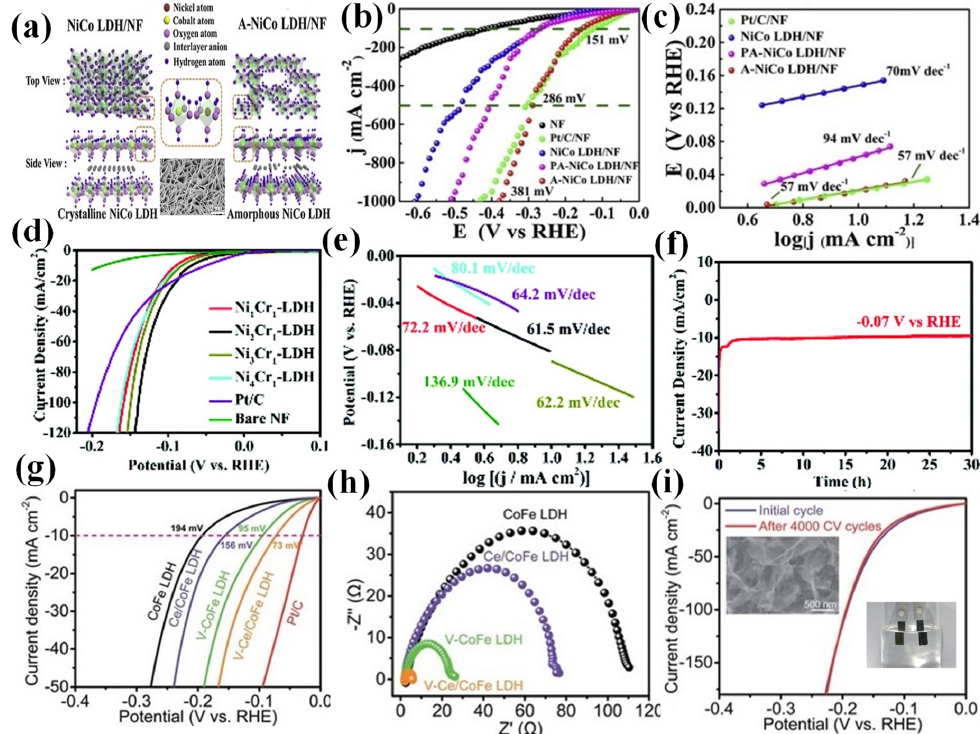
Figure 9. ( a ) Structure of boron-doping-induced amorphization of crystalline Ni-Co LDH nanosheets supported on nickel foam (denoted as A-Ni-Co LDH/NF); ( b ) LSV polarization curves and ( c ) Tafel plots of bare NF, Pt/C/NF, NiCo LDH/NF, PA-NiCo LDH/NF and A-NiCo LDH/NF for HER in 1 M KOH [85]; ( d , e ) graphical representation of polarization curves and the Tafel plots of different composites of LDHs, i.e., Ni 1 Cr 1 , Ni 2 Cr 1 , Ni 3 Cr 1 , Ni 4 Cr 1 hybrid with LDH, foam of bare Ni and RuO 2 ; ( f ) curve of time dependence between electrode of reduced hydrogen of Ni 2 Cr 1 composites with LDH and density of current below the potential value of −0.07 V [86]; ( g ) corrected polarization curves; ( h ) Tafel plots of CoFe LDH,V-CoFe LDH, Ce/CoFe LDH, and V-Ce/CoFe LDH in 1 M KOH electrolyte; ( i ) corrected polarization curves of V-Ce/CoFe LDH initially and after 4000 CV cycles [54].